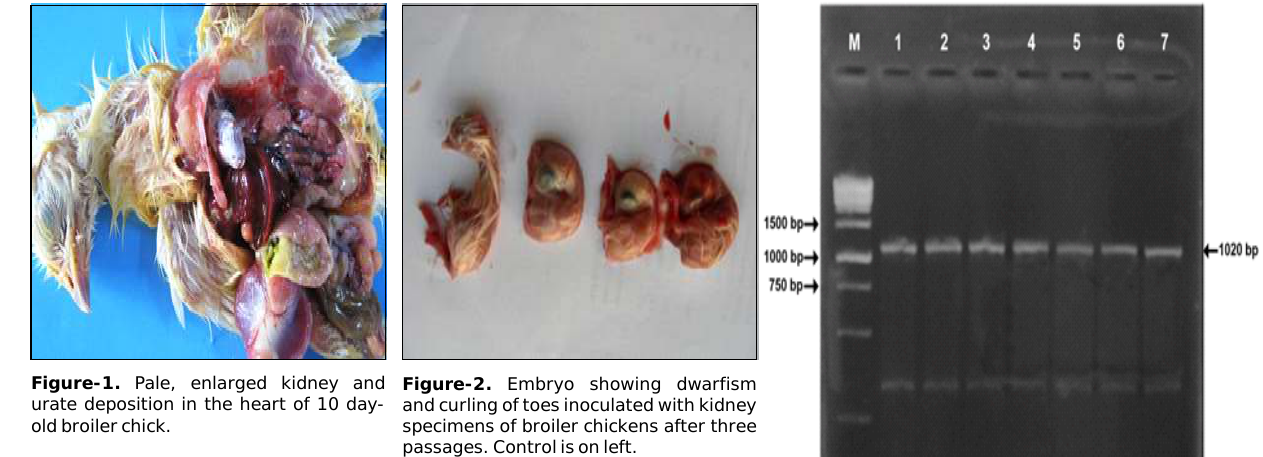
Figure-1. Pale, enlarged kidney and Figure-2. Embryo showing dwarfism urate deposition in the heart of 10 day- and curling of toes inoculated with kidney old broiler chick. specimens of broiler chickens after three passages. Control is on left. Figure-3. Agarose gel (1.5 per cent) electrophoresis of RT-PCR product obtained by amplifying part of M and N gene by using the primers MIBVPCR and NIBVPCR of field isolates and vaccine strain H120; Lane M: 500 bp marker; Lane 1 to 6: Field isolates; Lane 7: Vaccine strain